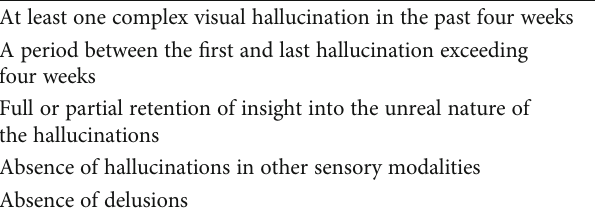
Table 1: The criteria laid out by Teunisse et al. (1996). At least one complex visual hallucination in the past four weeks A period between the fi rst and last hallucination exceeding four weeks Full or partial retention of insight into the unreal nature of the hallucinations Absence of hallucinations in other sensory modalities Absence of